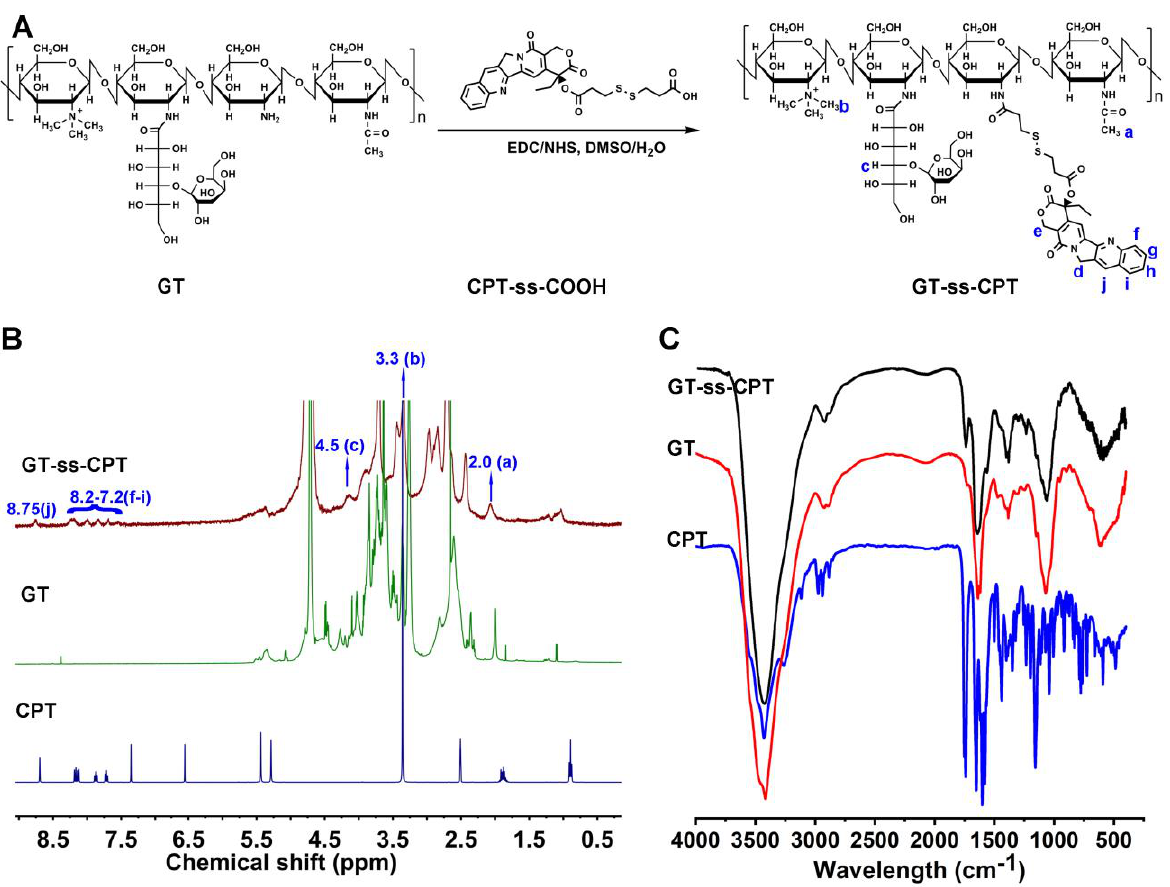
Figure 1. Synthesis and characterization of GT-ss-CPT conjugate. ( A ) Synthetic scheme of GT-ss-CPT conjugate. ( B ) 1 H NMR spectra and ( C ) FTIR of GT-ss-CPT conjugate, GT, and free CPT.